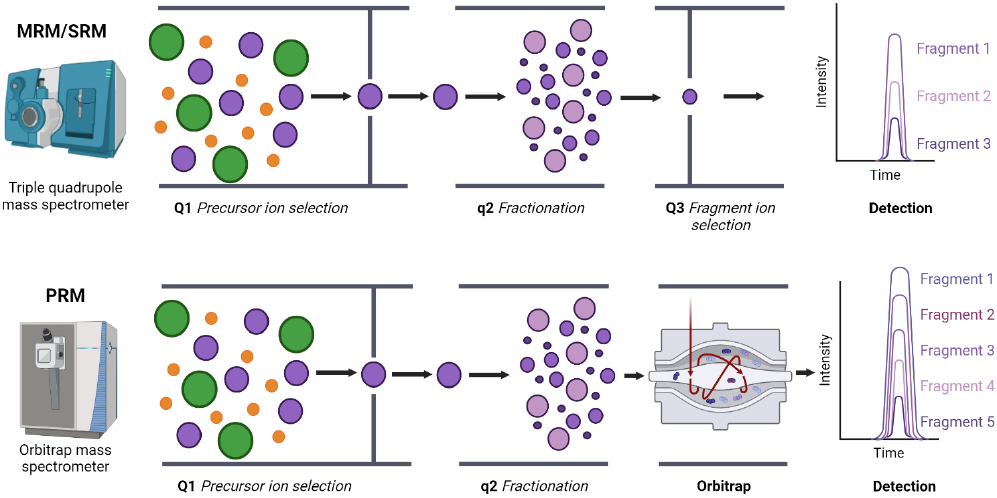
Figure 5. Multiple/selected reaction monitoring (MRM/SRM) and parallel reaction monitoring (PRM) targeted proteomics . MRM or SRM targeted proteomics experiments are performed in triple quadrupoles mass spectrometers while PRM experiments are performed in orbitrap high resolution mass spectrometers. In PRM experiments, intensity values of all fragments from a precursor ion are available, allowing a more robust quantification.